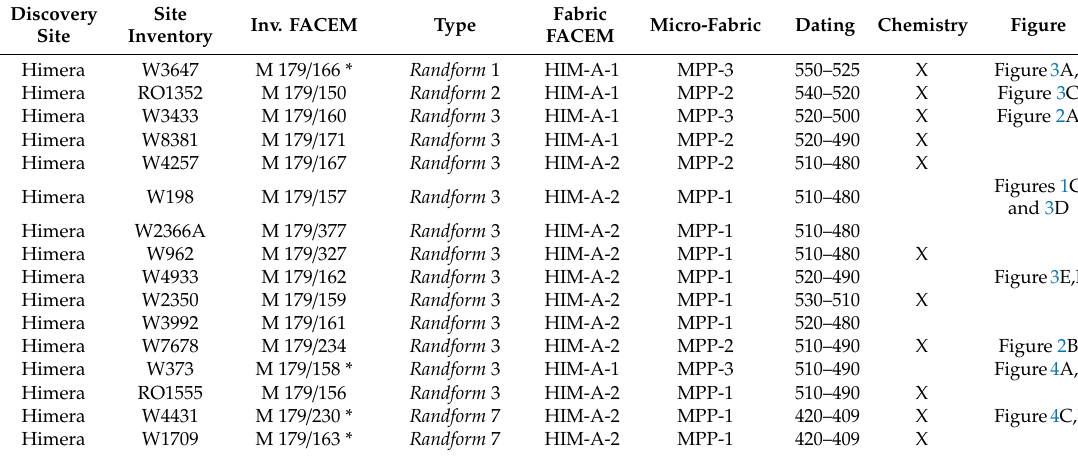
Table 1. Synopsis of data related to western Greek amphorae produced in Himera and provided with petrographic analysis. Typological identification referred to [22].